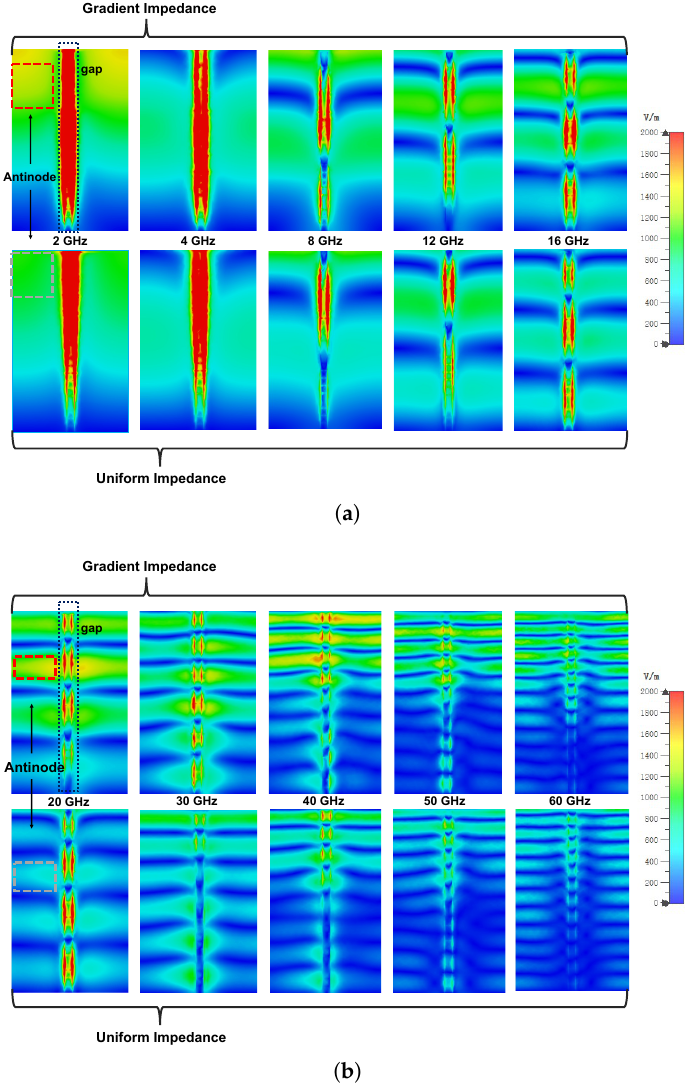
Figure 6. Electrical field distributions at different frequencies. Upper row is gradient impedance with 400, 200, and 100 Ω / (cid:3) . Lower row is uniform impedance with 200 Ω / (cid:3) . ( a ) 2–16 GHz. ( b ) 20–60